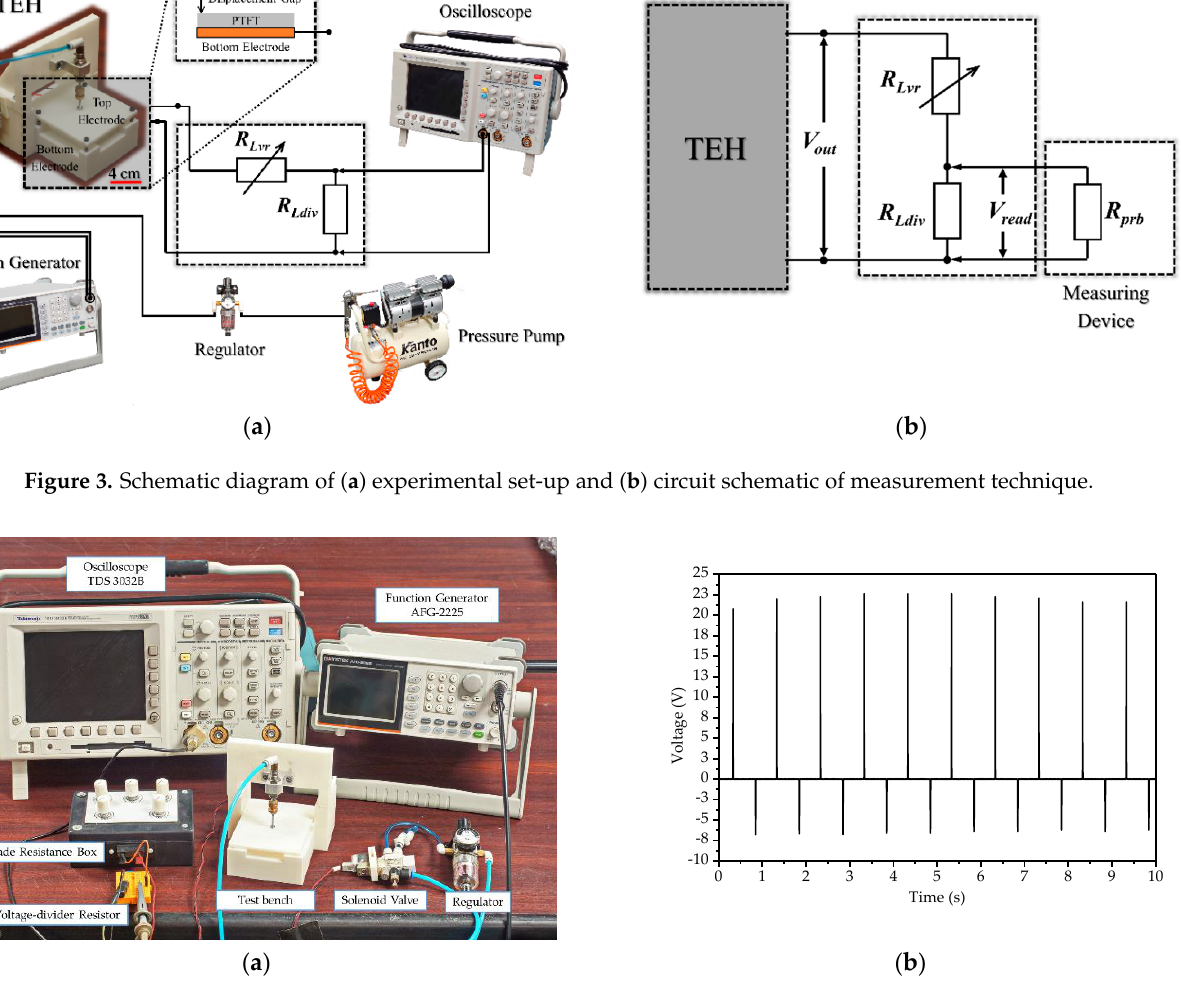
Ratio of R Ldiv : R prb Figure 5. Plot of measurement errors of output power, P L , versus six different ratios (1:1, 1:2, 1:5, 1:10, 1:100, and 1:1000) of voltage-divider resistance R Ldiv to probe resistance R prb . 4. Results and Discussion This section mainly discusses the main results of the experiment detailed in the pre- vious section. The experimental results demonstrate that the developed technique was more accurate, i.e., with smaller error, in determining the TEH output power than the conventional technique, as illustrated in Figure 6 (exact numerical values of all parameters are tabulated in Table 3). Moreover, it can be seen clearly in Figure 6b that the curve of measured power versus load resistance from this proposed technique approaches closer